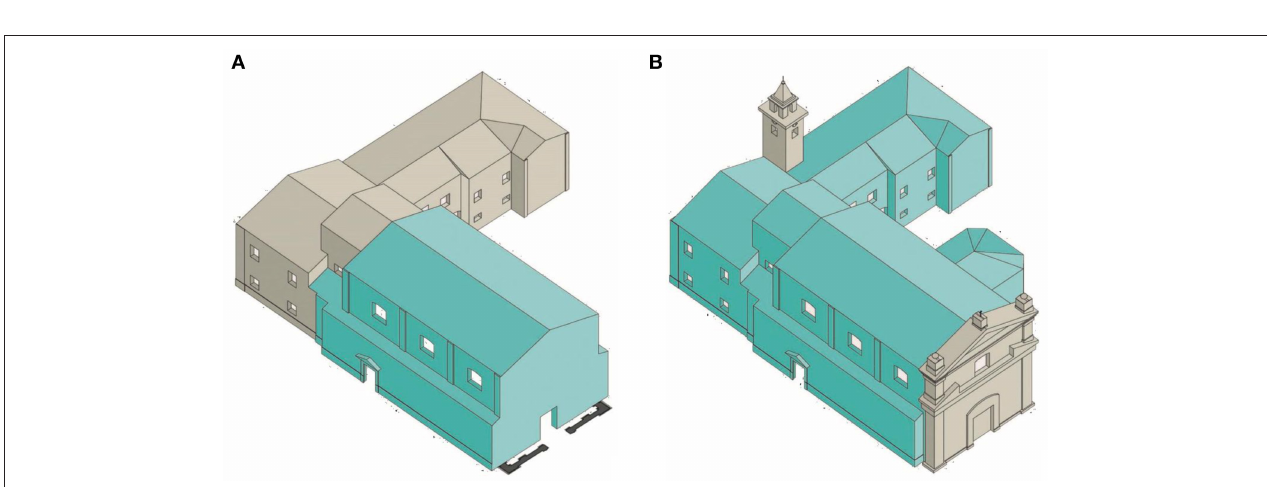
FIGURE 2 | Transformed configuration dated back to the 1814 of the SS. Rosario church (A) and renovation intervention of the façade in 1890 (B) .